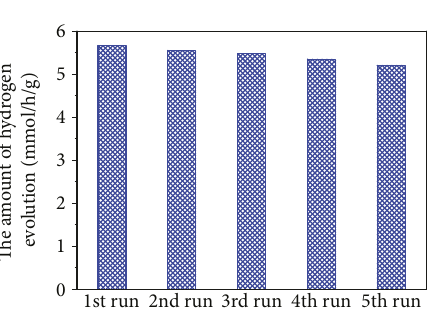
Figure 7: Recycling of 20 wt% CoS/TiO H 2 . 2